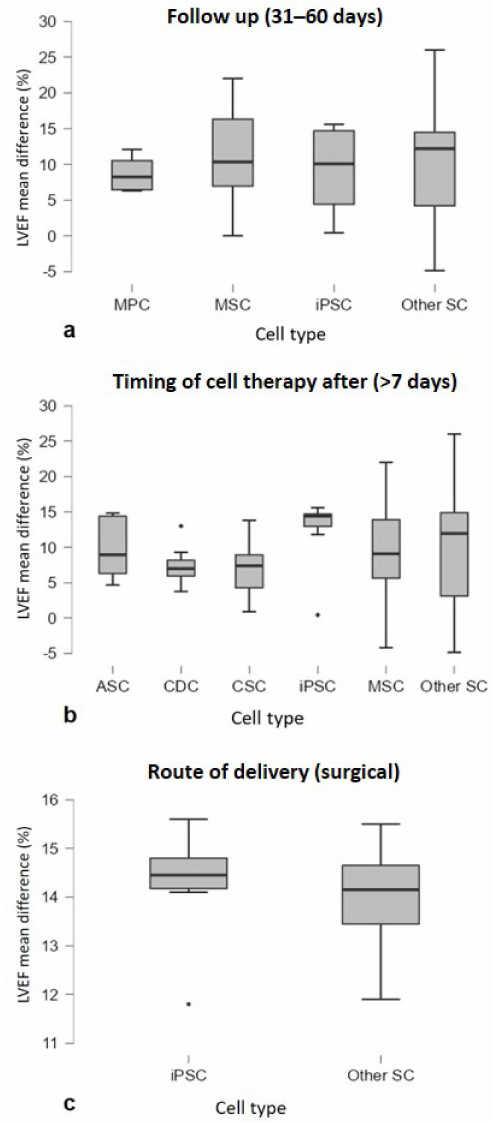
Figure 4. Subgroup analysis showing LVEF trends of cell type ( n > 3 studies) by considering studies of the three significant predictors, in particular ( a ) follow-up (30–60 days) ( p = 0.904), ( b ) timing of cell therapy after MI (>7 days) ( p = 0.690) and ( c ) route of delivery (surgical) ( p = 0.729). Graphs are represented as Boxplots; the two segments that delimit the rectangle represent the 25th and 75th percentiles; the central segment is the median; the bars represent the minimum and maximum values, respectively; and the external points the